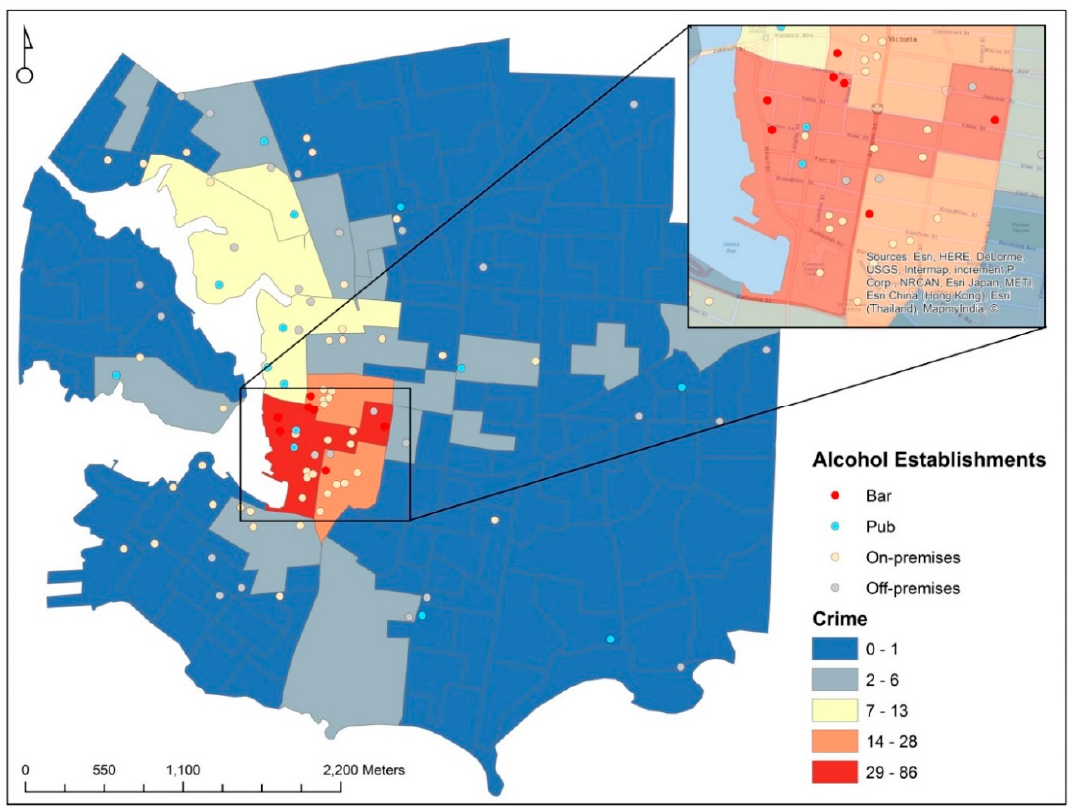
Figure 1. Victoria study area displaying the spatial distribution of crime and alcohol establishments.